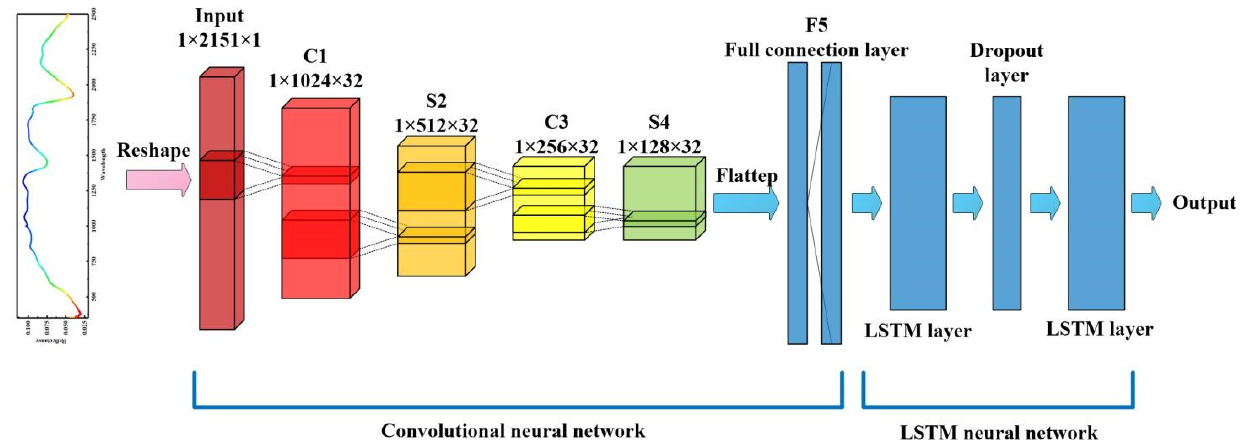
Figure 5. One-dimensional convolutional neural network model structure.